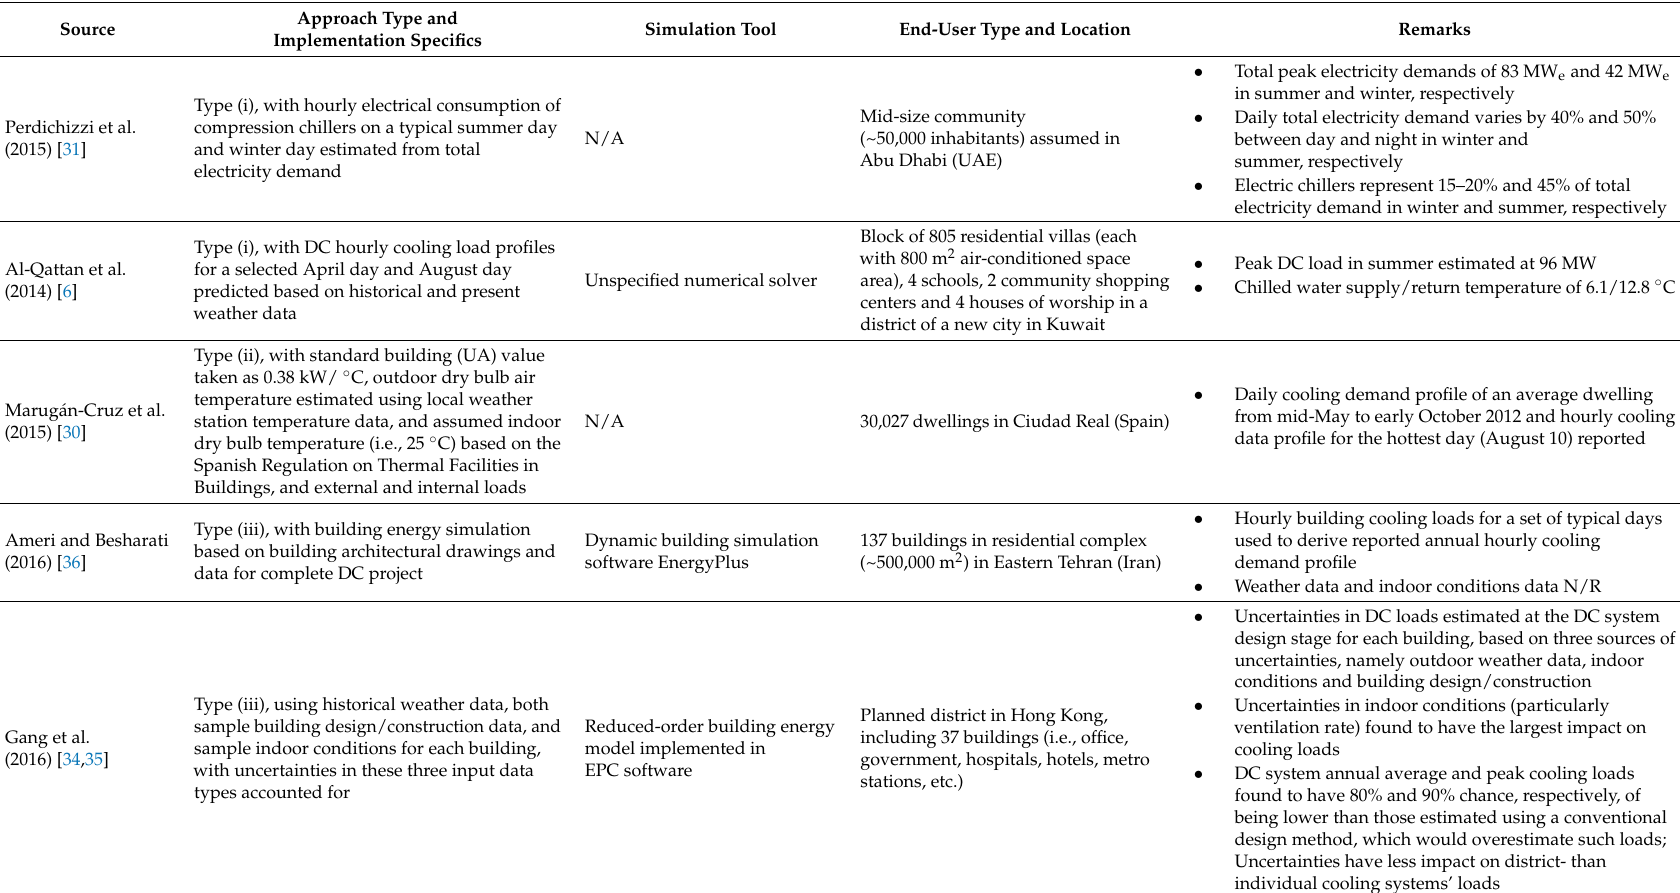
Table 3. Overview of district-level cooling load evaluation and analysis methodologies in DC design/analysis